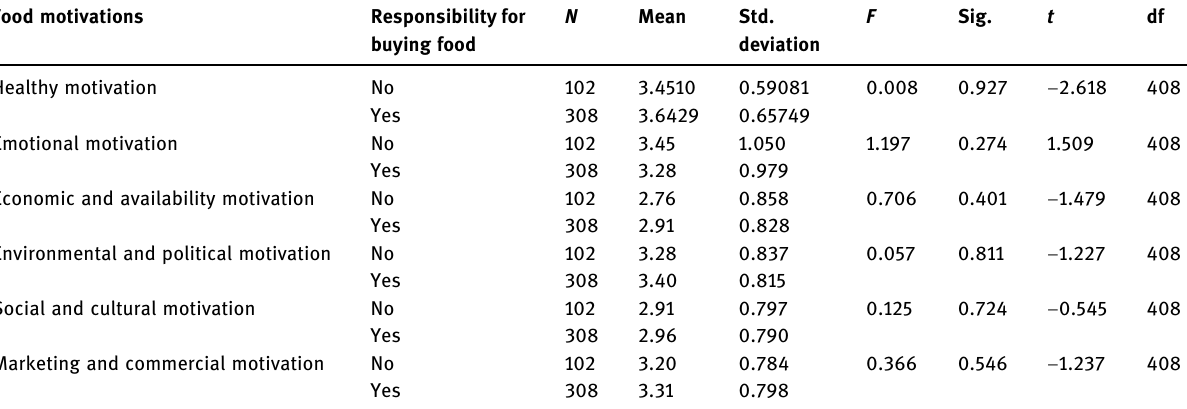
Table 2: T - test for gender and responsibility in buying food results Food motivations